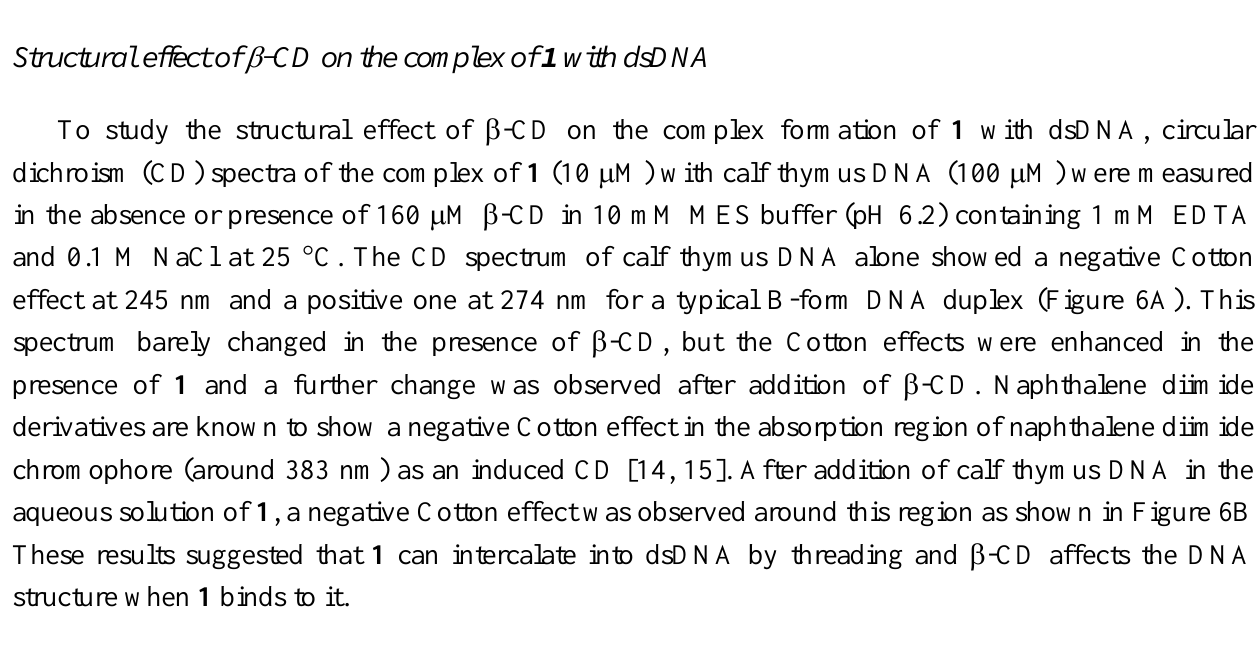
Figure 6. (A) CD spectra of 100 µ M sonicated calf thymus DNA in the presence of 1 and/or β -CD in 10 mM MES buffer (pH 6.2) containing 1 mM EDTA and 0.1 M NaCl at 25 ° C: ( □ ) DNA alone; ( ■ ) DNA + 10 µ M 1 ; ( ● ) DNA + 10 µ M